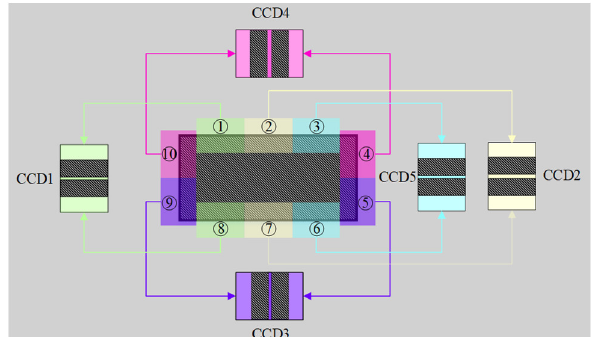
Figure 4. Prisms merge the light.